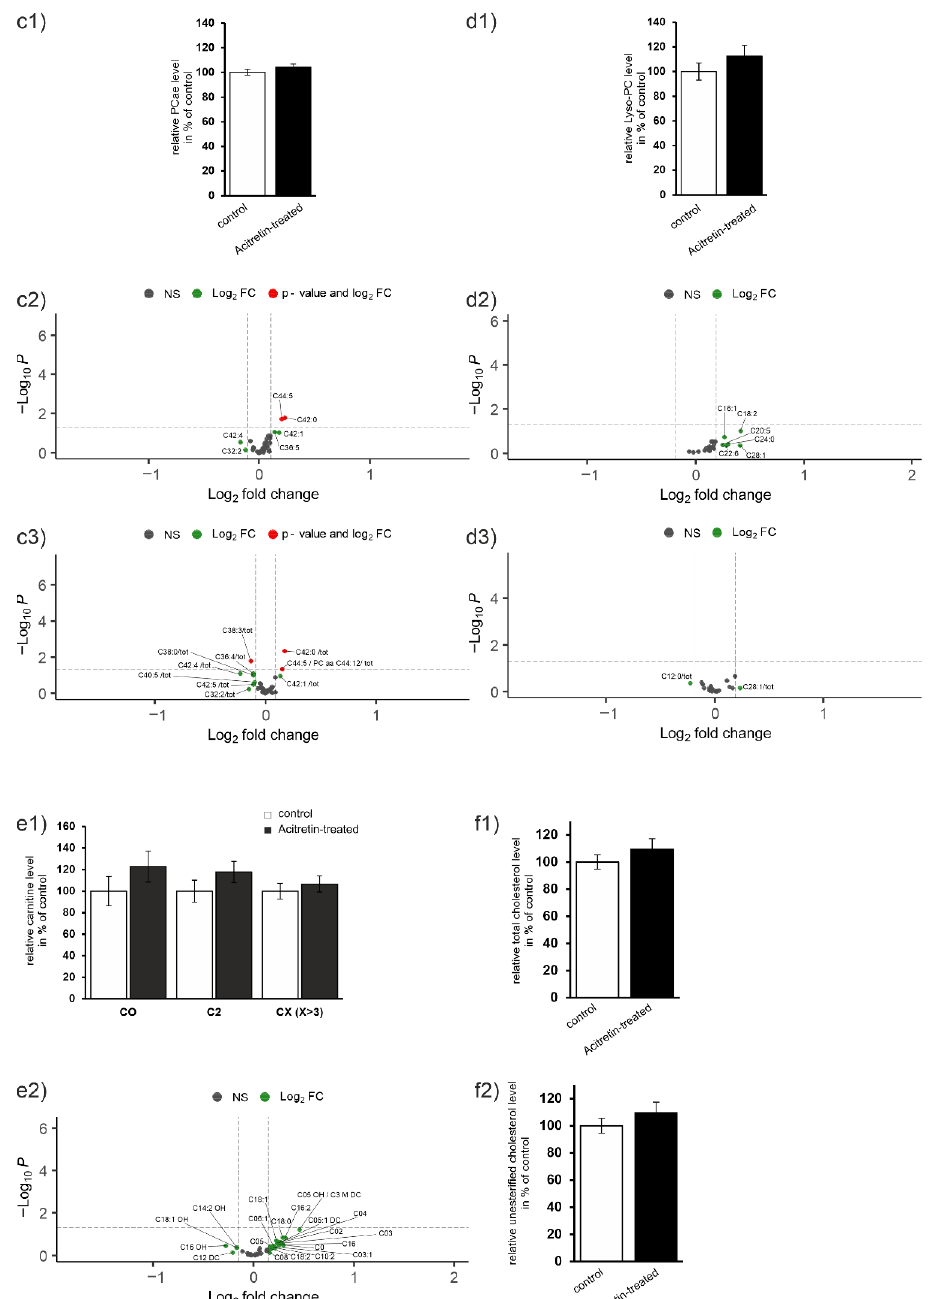
Figure 5. Lipid species in brain parenchyma of wild type mice treated with acitretin. Mice were treated as described (Figure 1) and lipids from total brain extracted by combination of mechanical and chemical treatments. Lipid species were identified by mass spectrometry: ( a ) triacylglycerides (TAG), ( b ) phosphatidylcholine (PC aa), ( c ) plasmalogens (PC ae), ( d ) lyso-PC, ( e ) carnitines (1: relative change of groups; 2: individual carnitines), and ( f ) total cholesterol ( f1 ) and unesterified cholesterol ( f2 ). Sphingomyelins (SM) can be found in Supplementary Figure S4 and effect sizes for all significantly affected species in Supplementary Figure S5. Subfigures ( a1 – d1 ) display change in % of the whole lipid class. Figures ( a2 – d2 ) show individual lipids and ( a3 – d3 ) individual lipids normalized to the whole lipid class. Statistical significance of the mean effects in liver tissue of acitretin-treated mice compared to control mice was calculated using two sample t -test (n = 6 animals per